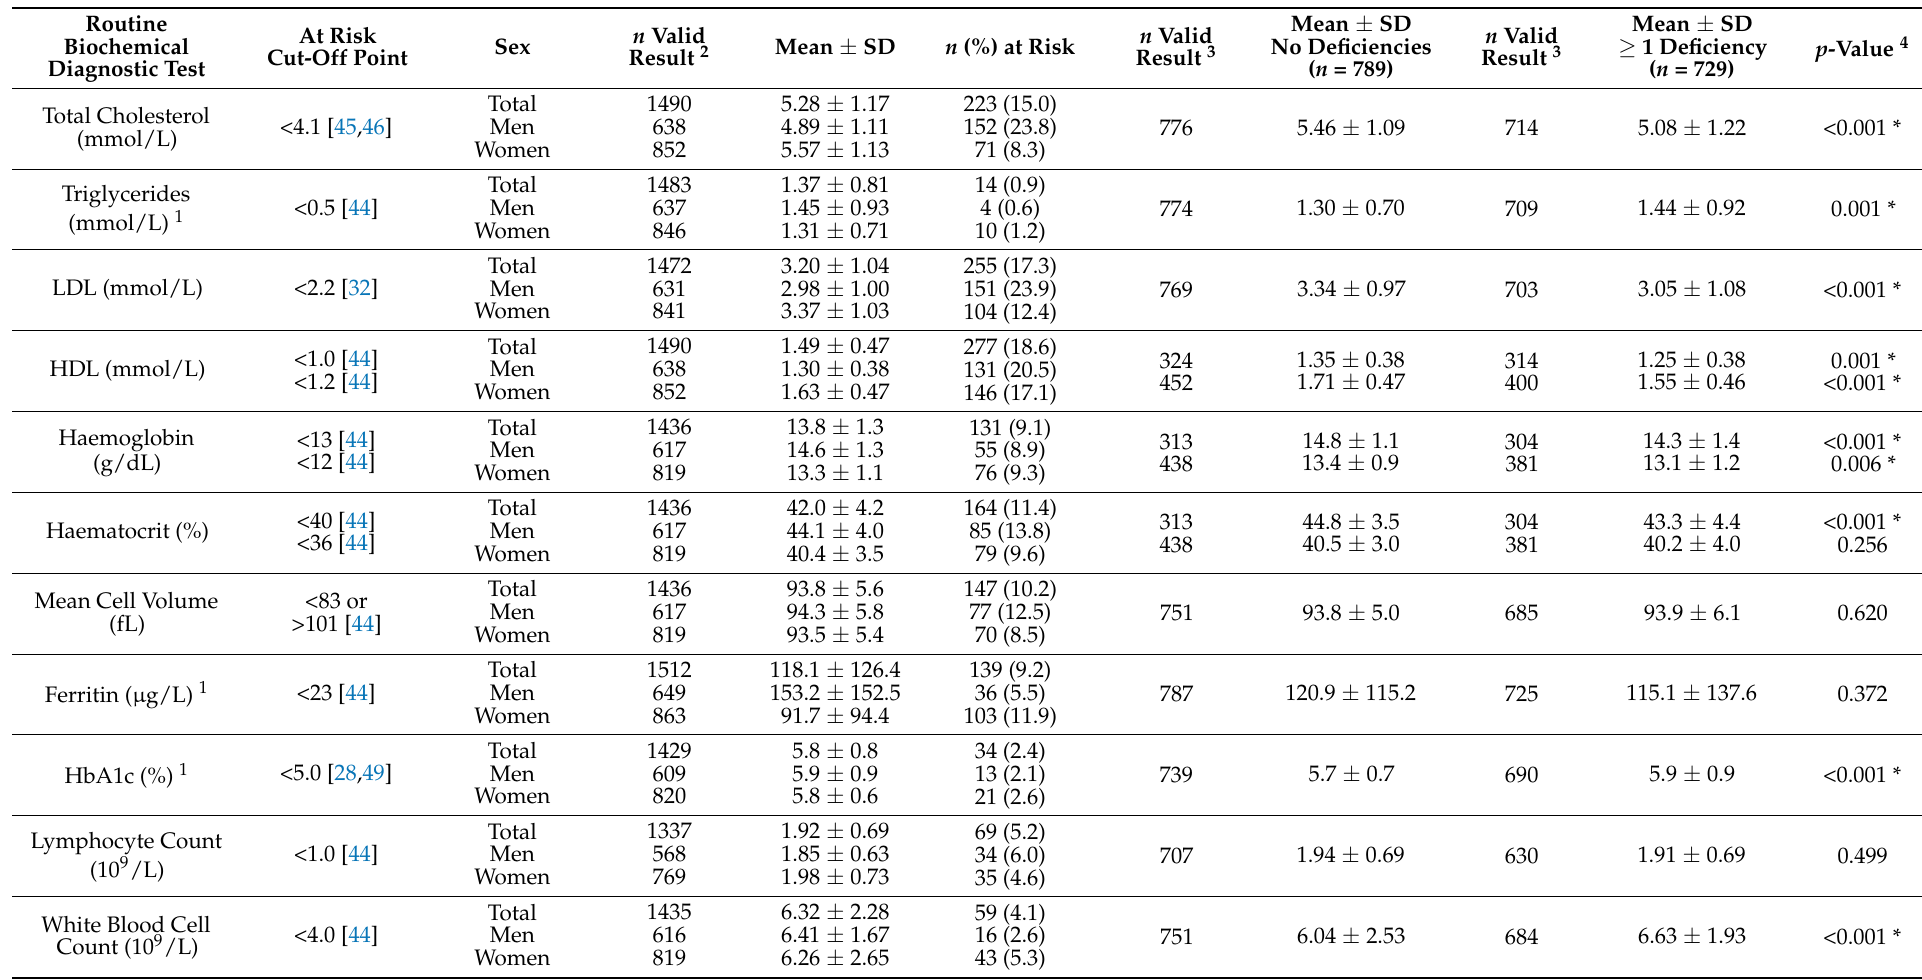
Table 3. Descriptives of routine biochemical diagnostic tests for subjects with a valid measurement and selected cut-off points to test relationships with poor nutritional status markers. Routine